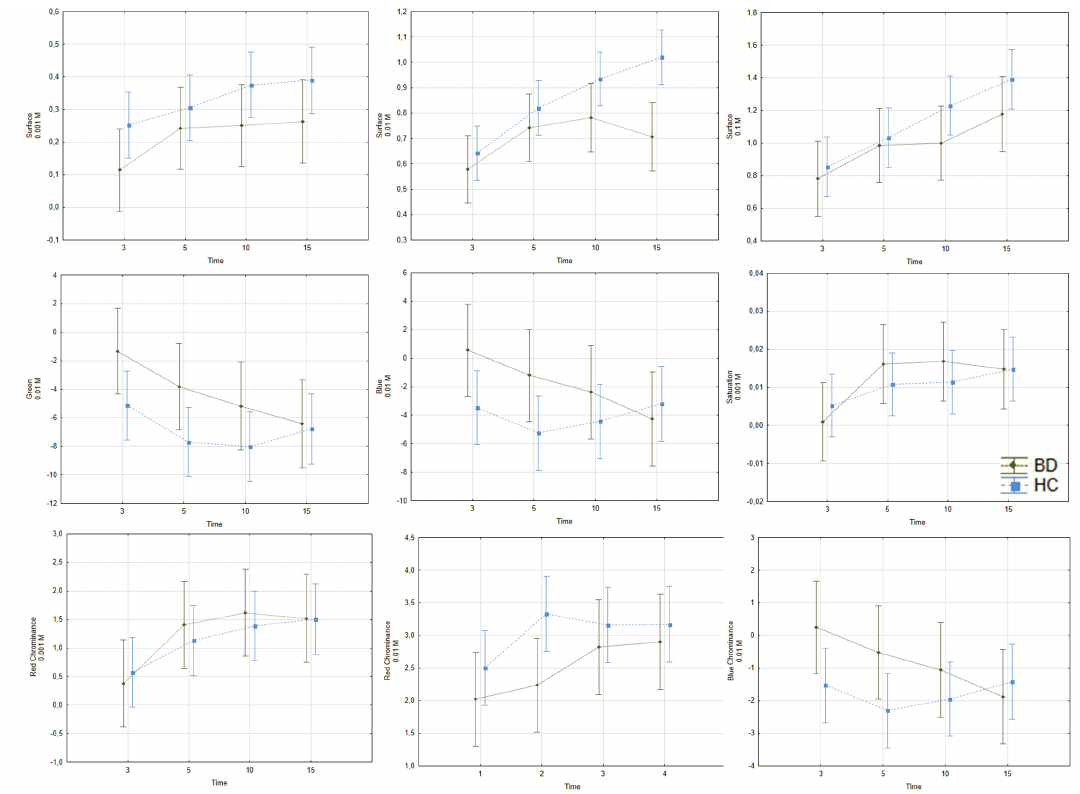
Figure 4. Di ff erences in response to niacin solution between HC and BD. The blue line—HC group, the green line—BD group, the vertical axis—skin color, the horizontal axis—time of measurement in minutes. Diagrams represent group and within-subjects e ff ects described in the Section